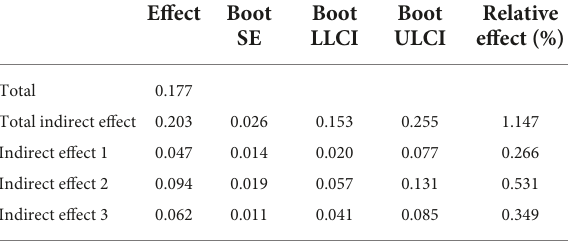
TABLE 3 Mediating paths between media multitasking and